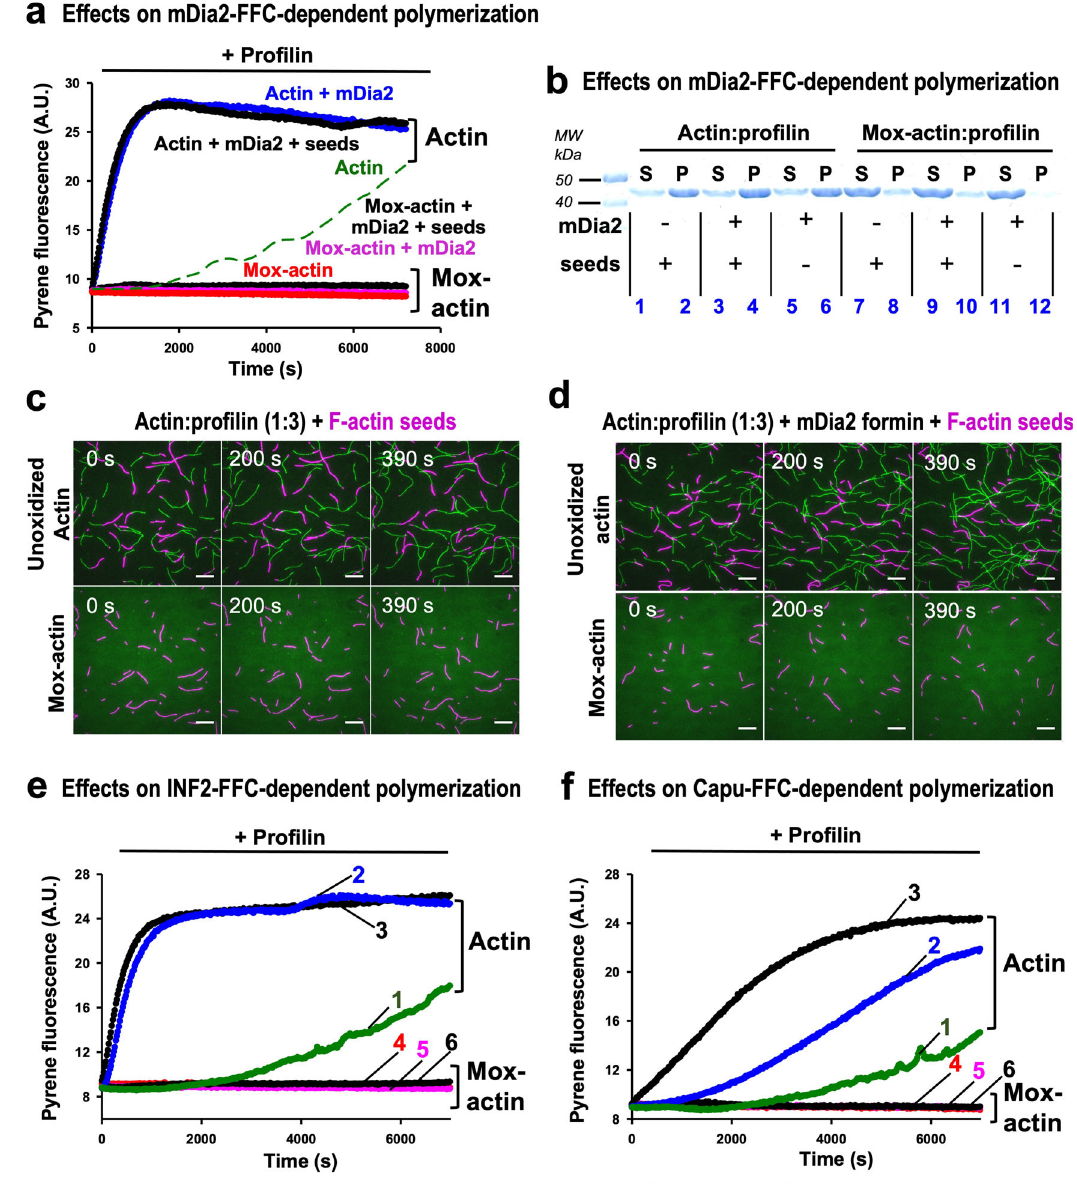
Fig. 2 Mox-actin – pro fi lin complexes markedly inhibit formin-dependent actin polymerization. a – d Assembly of unoxidized and Mox-actin in the presence of pro fi lin and mDia2-FFC formin construct (with or without phalloidin-stabilized F-actin seeds). Results obtained by three different methods — pyrene fl uorescence measurements ( a ), high-speed co-sedimentation ( b ), and TIRF microscopy ( c , d ) — are consistent with the absence of mDia2-FFC- -driven Mox-actin assembly in the presence of pro fi lin. n = 2 separate experiments with similar results for each of a – d . a , b [Actin] = 3 µ M; [pro fi lin] = 9 µ M; [mDia2-FFC] = 30 nM; [F-actin-phalloidin seeds] = 0.25 µ M (stabilized with phalloidin (Ph) at 1:50 Ph:actin molar ratio). A.U. arbitrary units. c , d [Actin] = 0.5 µ M, [Mox-actin] = 1.4 µ M (0.4 µ M above each of their critical concentrations); Pro fi lin-to-actin ratios = 3:1. [mDia2- FFC] = 1.5 nM. Note that the pro fi lin – actin control sample in ( a green trace) is a smoothed fi t through the data points and is therefore shown as a dashed line (see Source Data fi le). This condition is repeated in the green traces in Figs. 1d, 2e, 2f, and Supplemental Fig. 2. Scale bars ( c , d ) = 10 µ m. e , f INF2 ( e ) and Drosophila Capu ( f ) formins do not support Mox-actin assembly in the presence of pro fi lin. Traces obtained are labeled as follows (similar to Fig. 2a): 1 — Actin; 2 — Actin + formin; 3 — Actin + formin + seeds; 4 — Mox-actin; 5 — Mox-actin + formin; 6 — Mox-actin + formin + seeds. n = 2 separate experiments with similar results for each of e and f . [Actin] = 3 µ M; [pro fi lin] = 9 µ M; [INF2-FFC] = 10 nM; [Capu-FFC] = 20 nM; [F-actin-phalloidin seeds] = 0.25 µ M (stabilized with phalloidin (Ph) at 1:50 Ph:actin molar ratio). Note that formins have different potencies in promoting actin assembly (e.g., refs. 78,79 ). Therefore, different concentrations of formins ’ were used in the reactions. Source data for Fig. 2 including uncropped gels are provided as a Source Data fi